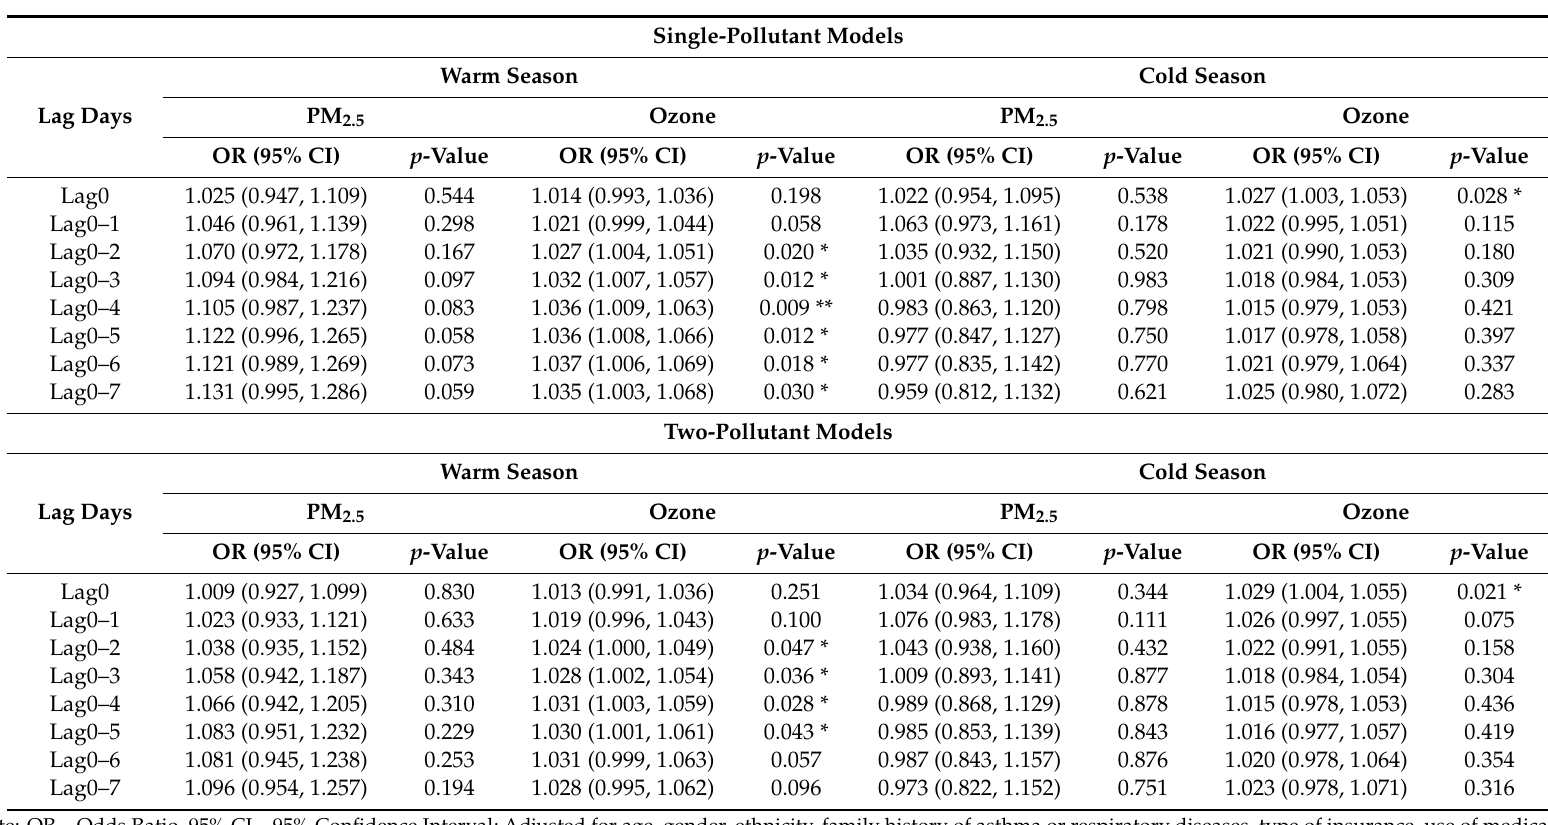
Table 6. Results of multivariate binomial logistic regression analysis stratified by season in single- and two-pollutant